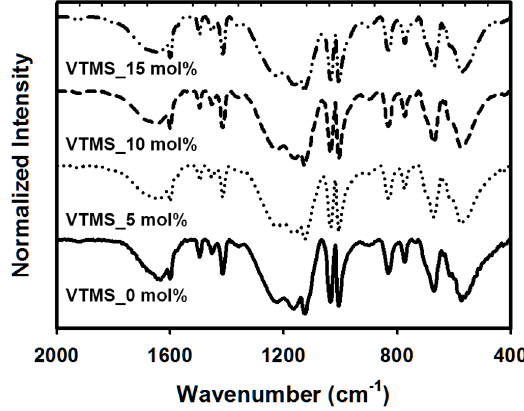
Figure 1. FTIR spectra of PSS and P(SS- co -vinyltrimethoxysilane (VTMS)) copolymers.